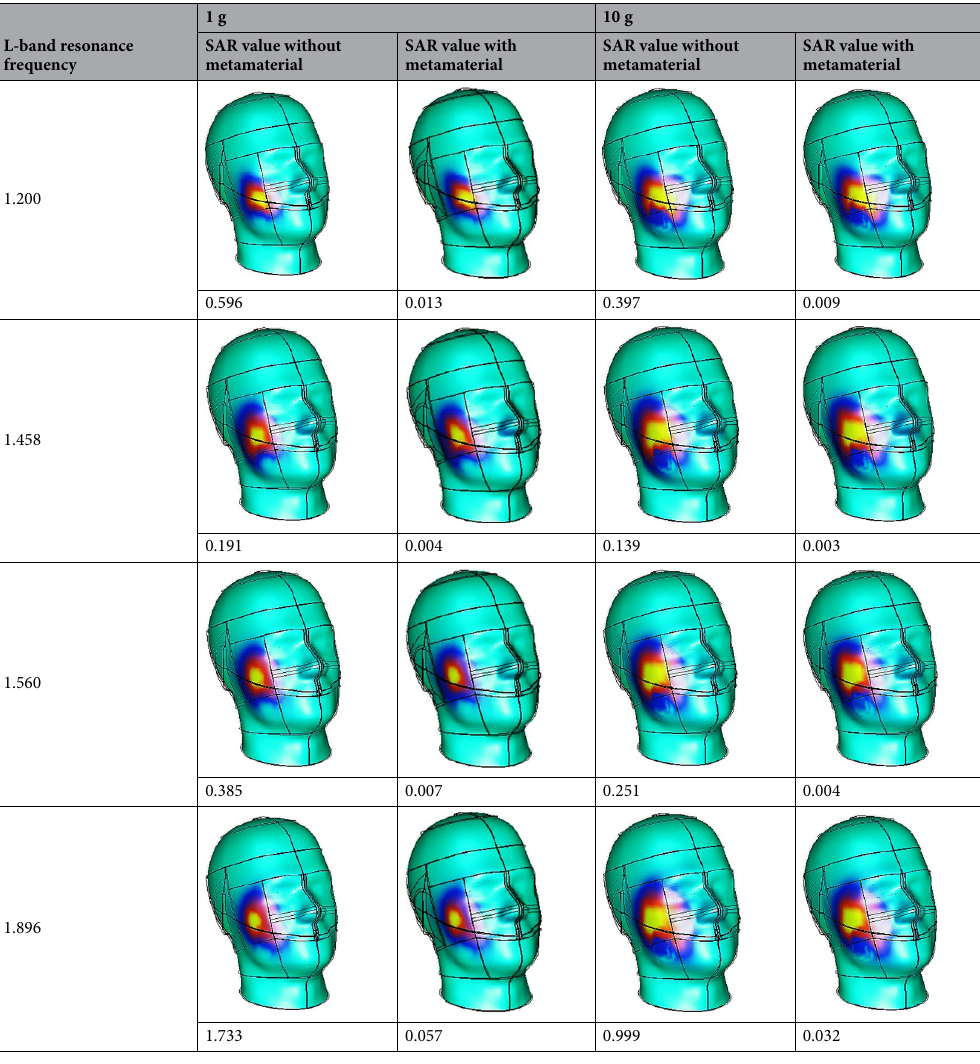
Table 5. SAR values of 1 g and 10 g of tissue volumes without and with the MSM design at